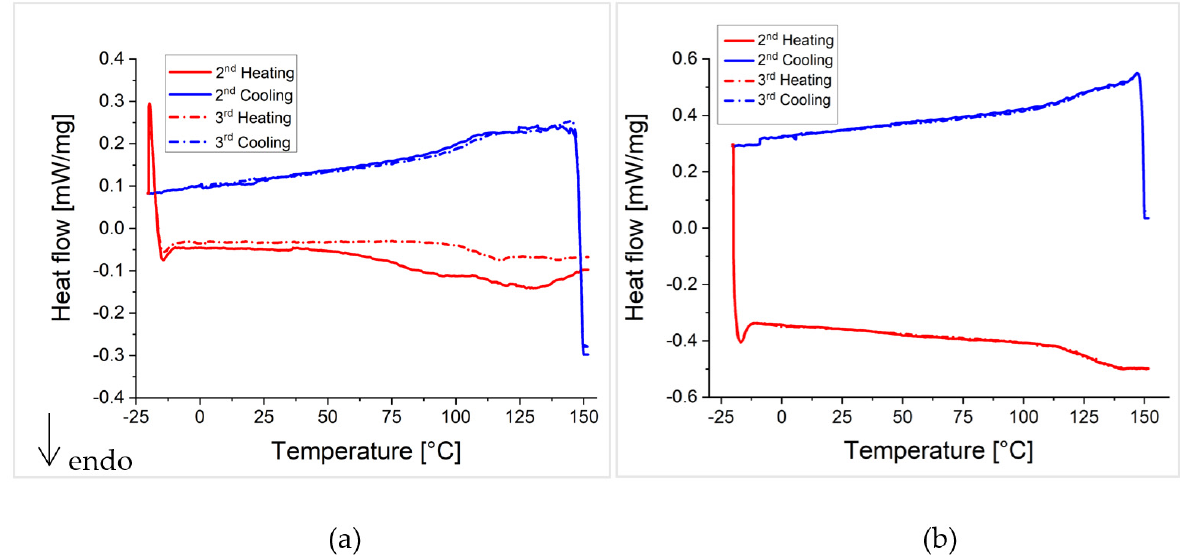
Figure 11. DSC heating (red) and cooling (blue) curves of the crosslinked P(MMA 89 - co -FMA 11 ) 24 . ( a ) Crosslinked P(MMA 89 - co -FMA 11 ) 24 with BMI in a motif ratio of 1:1. The endothermic step indicates the glass transition temperature around 110 °C in the 3 rd heating curve. ( b ) Crosslinked P(MMA 89 - co -FMA 11 ) 24 with P(MMA 74 - co -MIMA 26 ) 9 . The glass transition of the two copolymers occurs at around 120 °C.